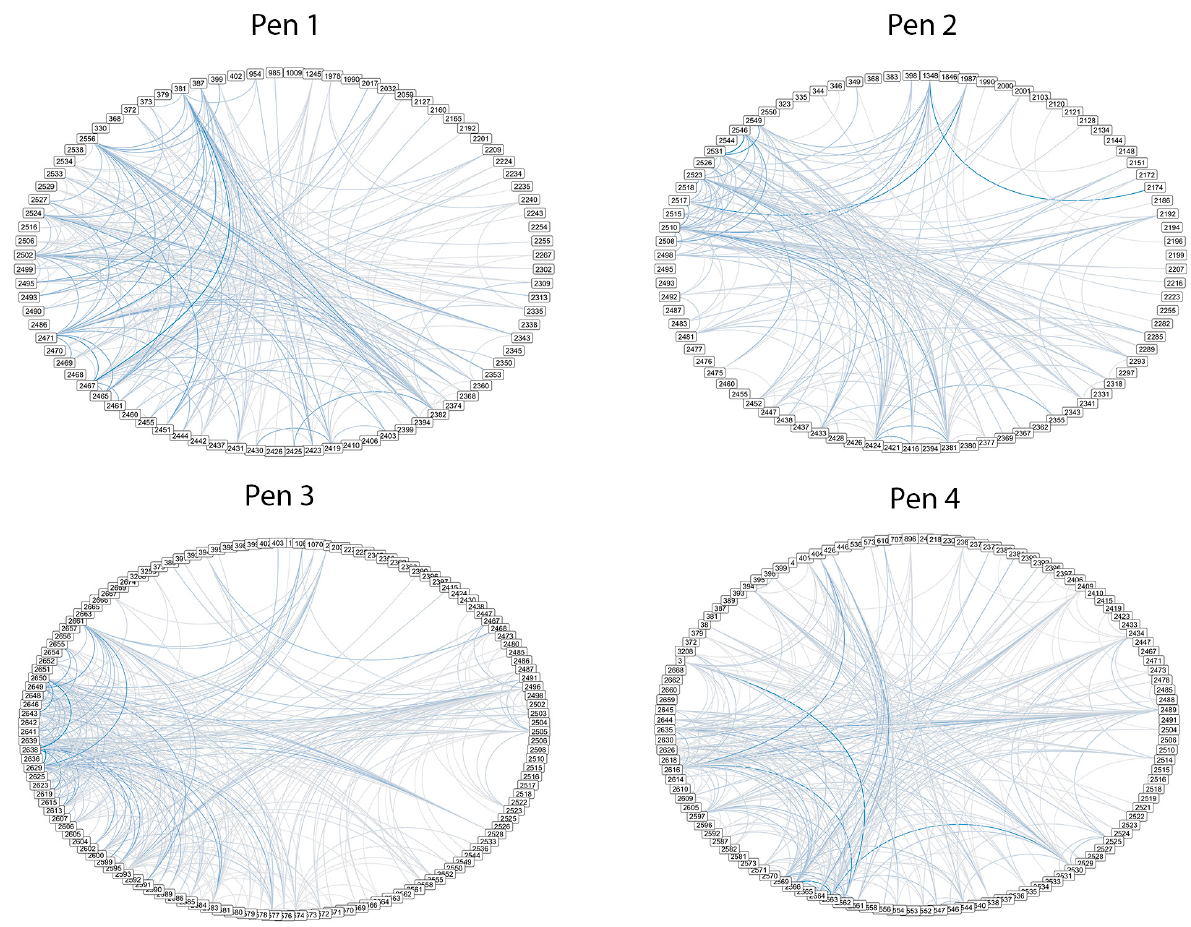
Figure 2. Network representation of pens’ social networks scored with the lag sequence decreasing score where the top 10% of network edge weights are shown. Each node is an individual cow (cow numbers forming the outer circle), and each edge (blue lines inside the circle) is a connection between cows with darker lines indicate strength of the relationship between the cows. Only the strongest 10% of the edges are shown to avoid oversaturation of lines. Table 4. Difference between actual and expected (predicted from Wood’s curve model) milk produc- Table 3. Social network metrics of the four pens. tion for periods with and without